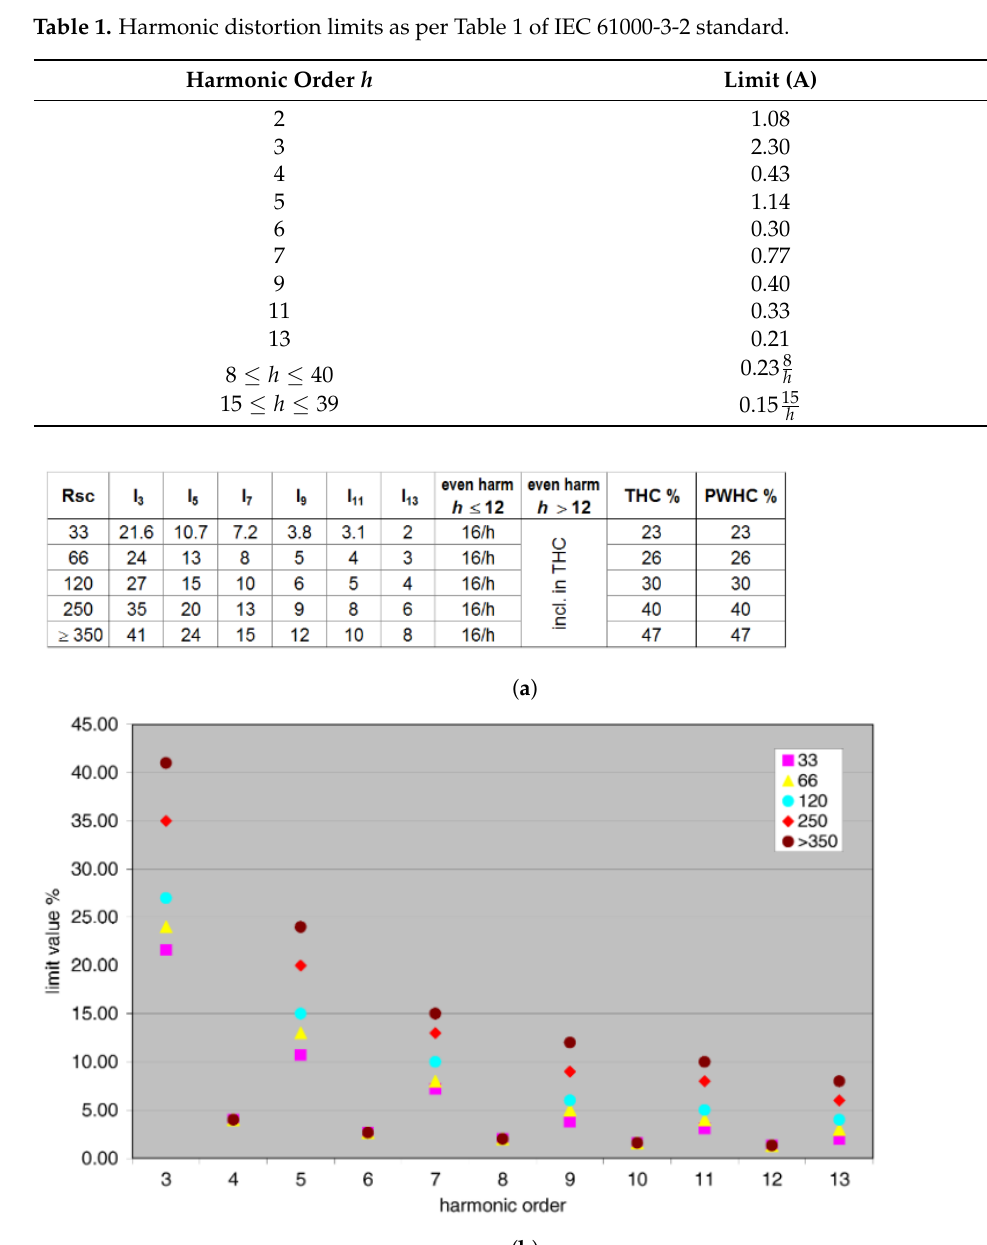
Figure 4. Harmonic distortion limits for unbalanced loads as a function of short-circuit ratio R sc (Table 2 of IEC 61000-3-12): ( a ) numeric values, ( b ) graphical